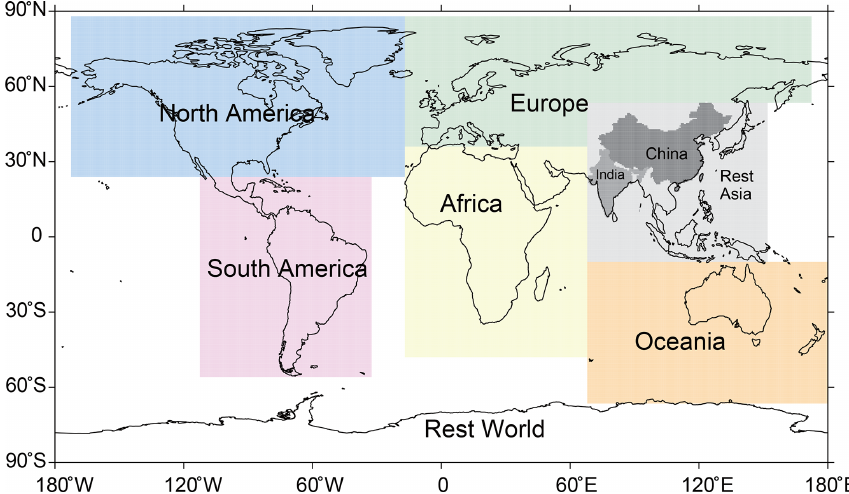
Figure 2. Regions defined in the tagged CH 4 tracer simulation. The regions are North America (NA), South America (SA), Europe (EU), Africa (AF), Oceania (OC), China (CHN), India (IND), and Rest of Asia (RtAS). All other areas are included in the rest of the world (RW)